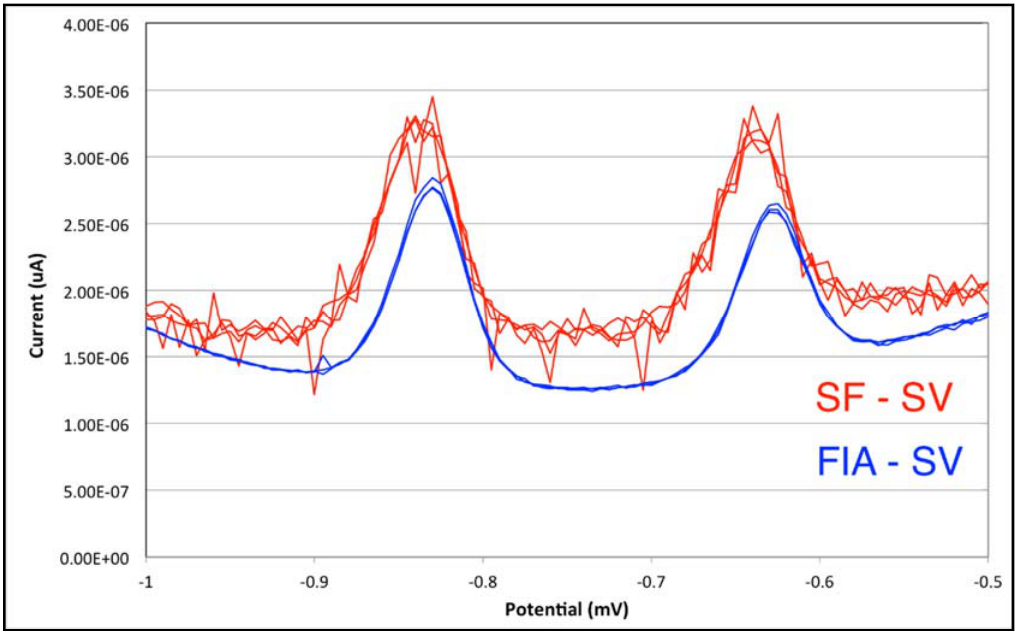
Figure 8. Comparison of analytical signals of Pb and Cd at 15 μ g/L obtained in stopped ‐ flow (SF ‐ SV red trace) and in flow injection (FIA ‐ SV blue trace) stripping voltammetry.